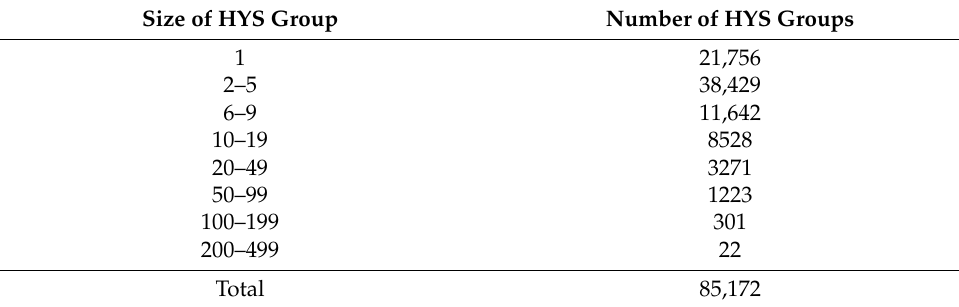
Table 3. Distribution of HYS